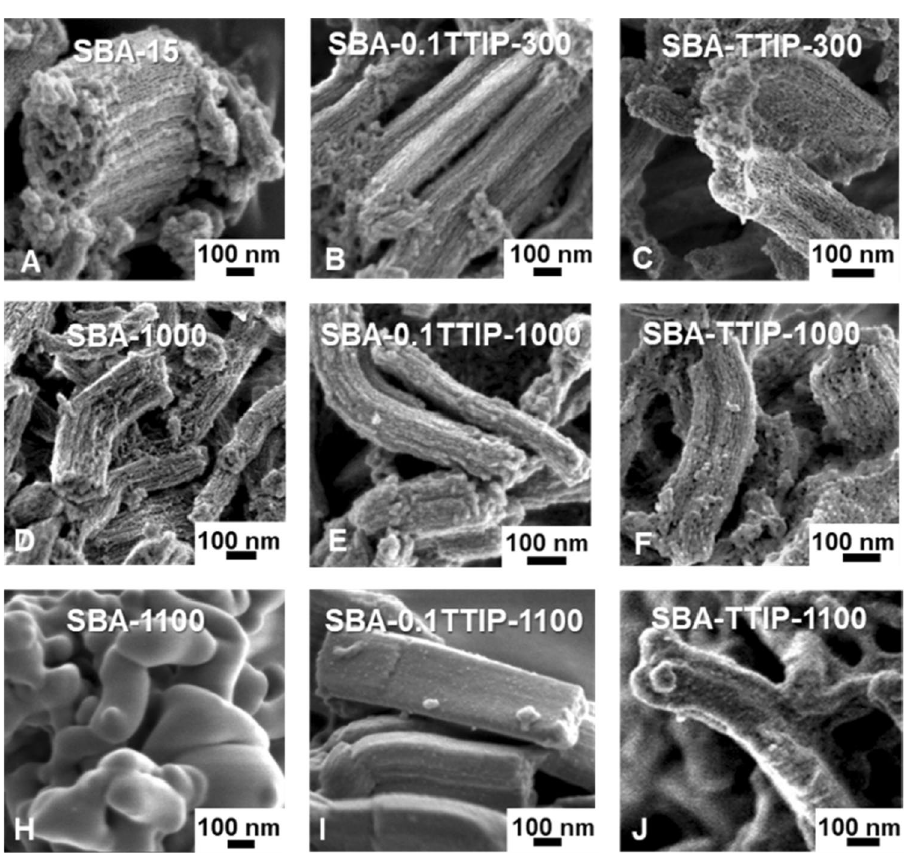
Figure 3. SEM images of ( A ) SBA-15, ( B ) SBA-0.1TTIP-300, ( C ) SBA-TTIP-300, ( D ) SBA-1000, ( E ) SBA- 0.1TTIP-1000, ( F ) SBA-TTIP-1000, ( H ) SBA-1100, ( I ) SBA-0.1TTIP-1100 and ( J )